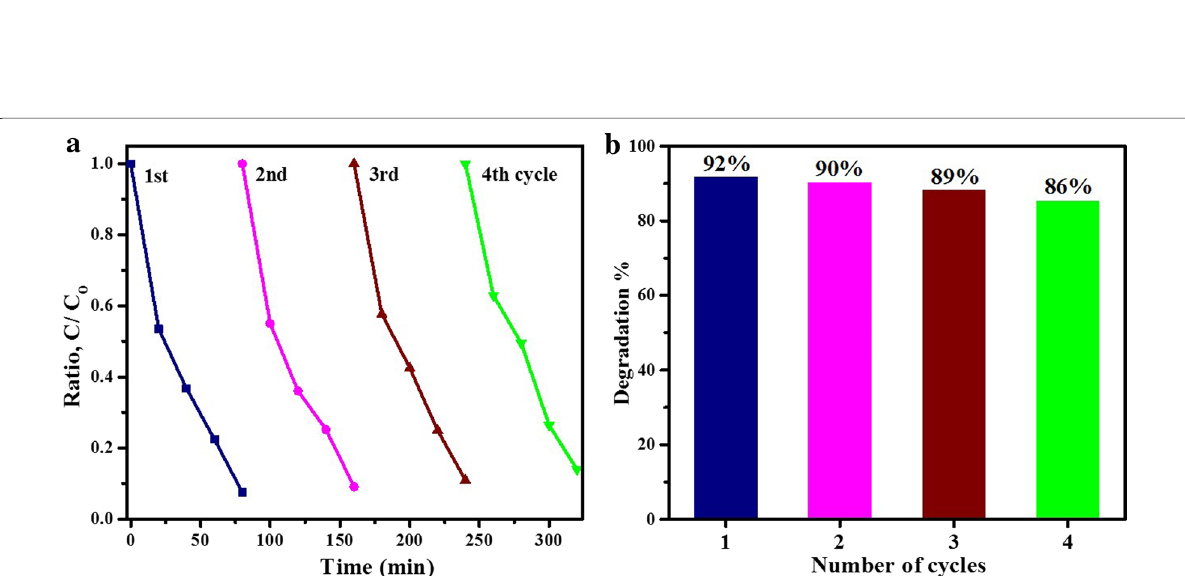
Fig. 10 a Reusability of tin oxide photocatalyst annealed at 500 °C and b degradation % bar